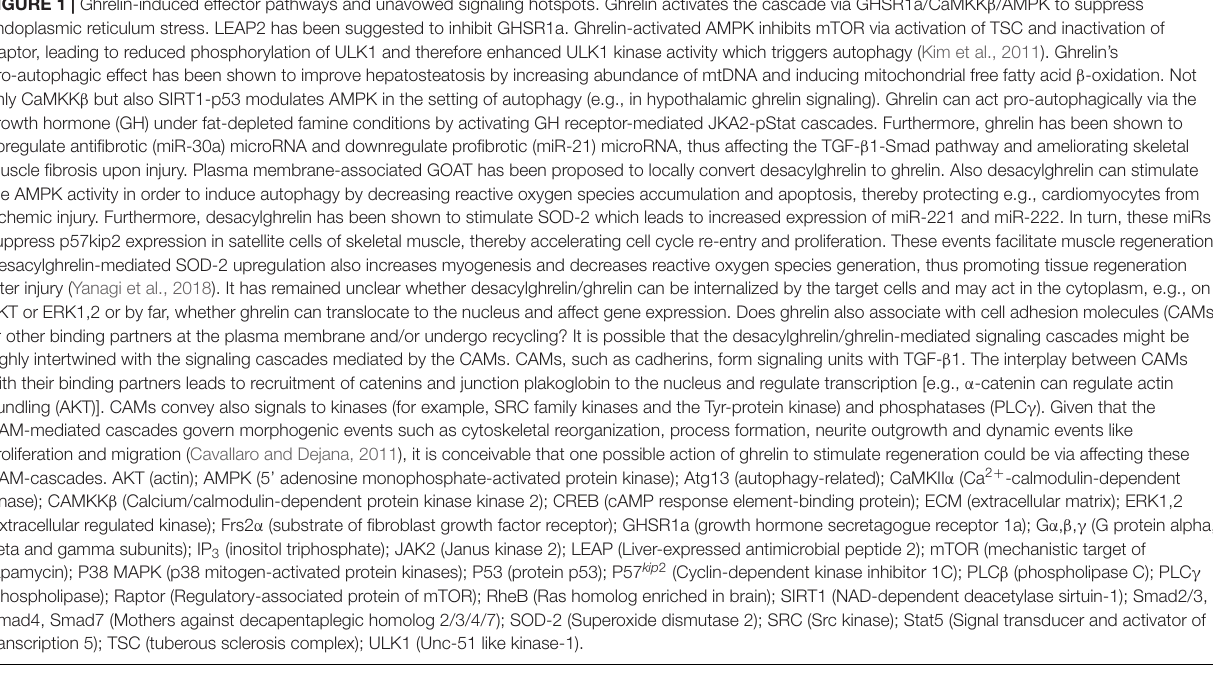
Frontiers in Cell and Developmental Biology |